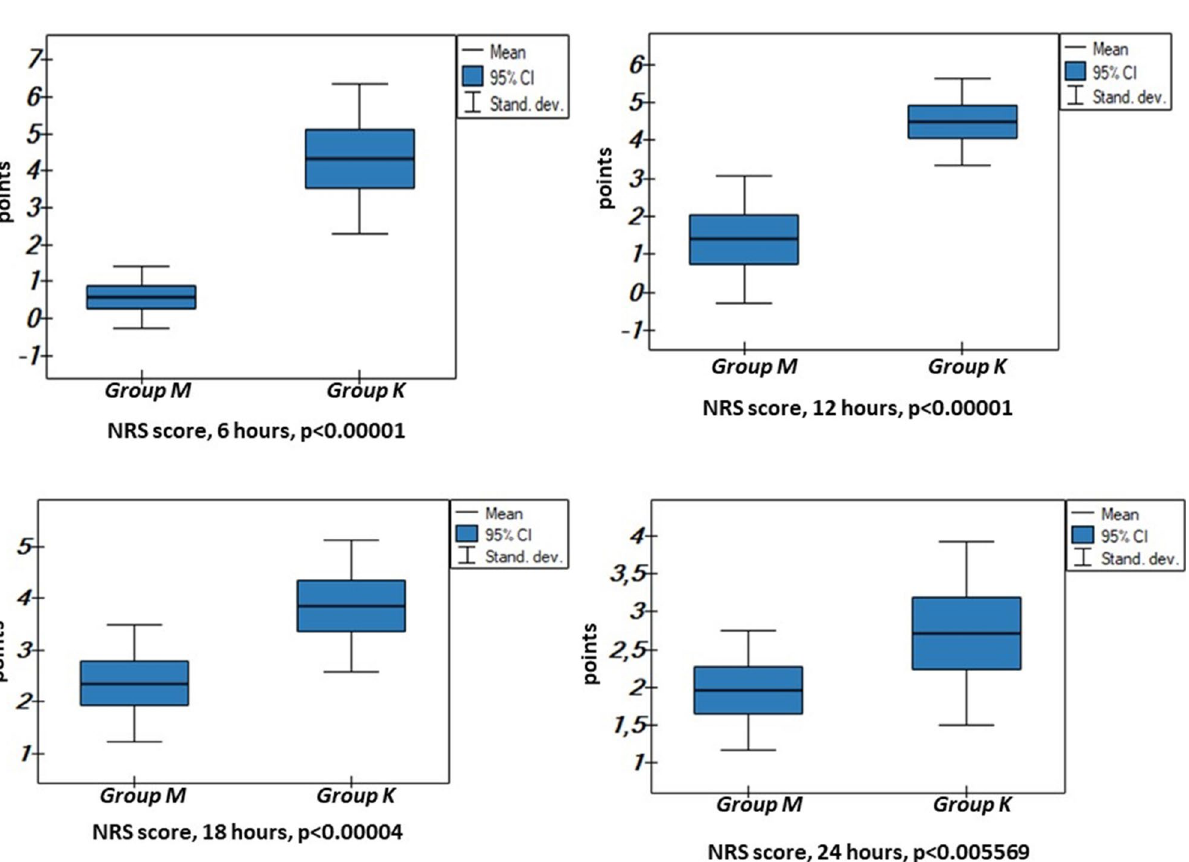
Figure 4. NRS level (points) at rest at time points at 6, 12, 18 and 24 h postoperatively in the analysed patients above 65 years of age divided into the study (M) and control (K)